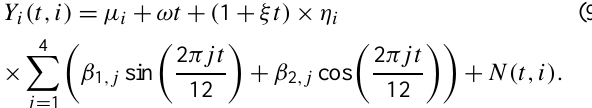
Fig. 20. Time series of monthly mean VCD trop NO 2 from GOME (blue), SCIAMACHY (red), OMI (green), and GOME-2 (cyan). The GOME measurements have been corrected for the instrument’s pixel size using the mechanism presented in Sect. 4.